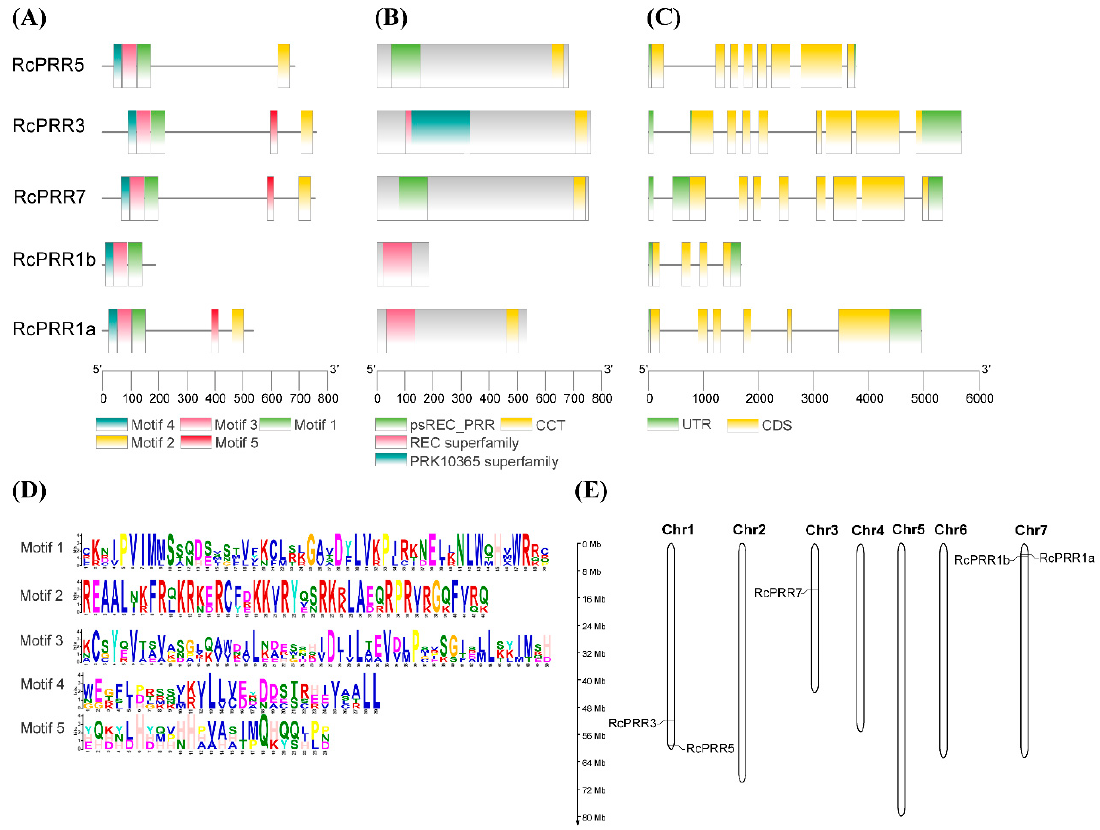
Figure 3. Conserved motifs and domains, gene structure organization, and chromosomal localization of clock PRRs in Rosa chinensis . ( A ) discovered motifs; ( B ) discovered domains; ( C ) gene structure organization; ( D ) logos of the identified motifs; and ( E ) chromosomal localization.